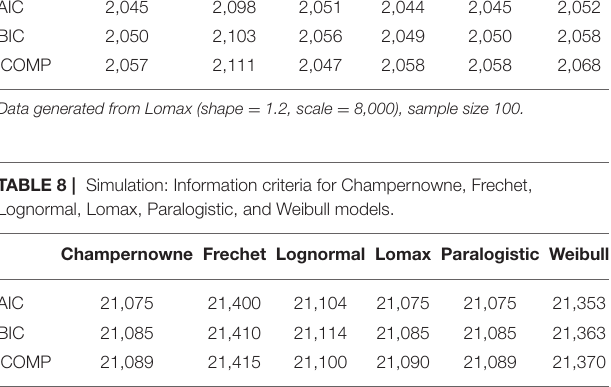
Data generated from Frechet (shape